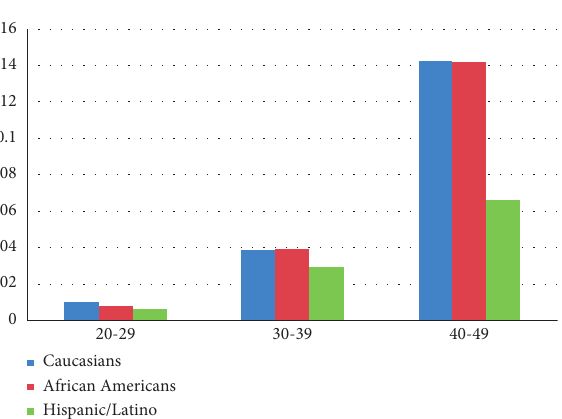
Figure 3: Prevalence of CRC in different race groups.